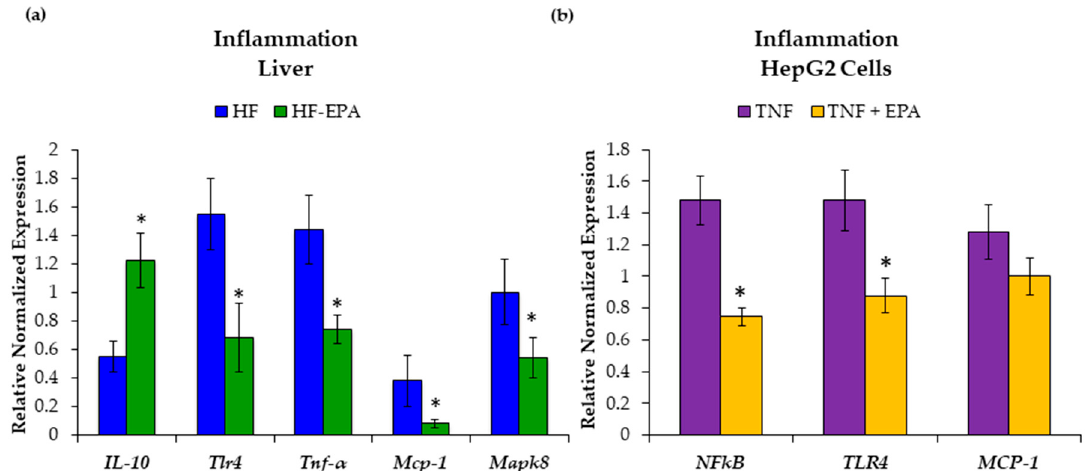
Figure 7. Eicosapentaenoic acid (EPA) supplementation reduces hepatic inflammation. ( a ) Gene expression studies indicate significant increases in anti-inflammatory marker, interleukin 10 ( Il-10 ) and significant decreases in pro-inflammatory markers: toll-like receptor 4 ( Tlr4 ), tumor necrosis factor-alpha ( Tnf- α ), monocyte chemoattractant protein-1 ( Mcp-1 ), and mitogen activated protein kinase 8 ( Mapk8 ) with EPA supplementation. Data are expressed as mean ± SEM, n = 6, p ≤ 0.05. ( b ) EPA supplemented to TNF- α treated HepG2 cells reduces inflammation. Gene expression studies indicate significant decreases in pro-inflammatory markers: nuclear factor kappa-light-chain-enhancer of activated B cells ( NF κ B ) and toll-like receptor 4 ( TLR4 ) with EPA supplementation. Reductions in monocyte chemoattractant protein-1 ( MCP-1 ) were not significant. Data are expressed as mean ± SEM, n = 6, * = p <